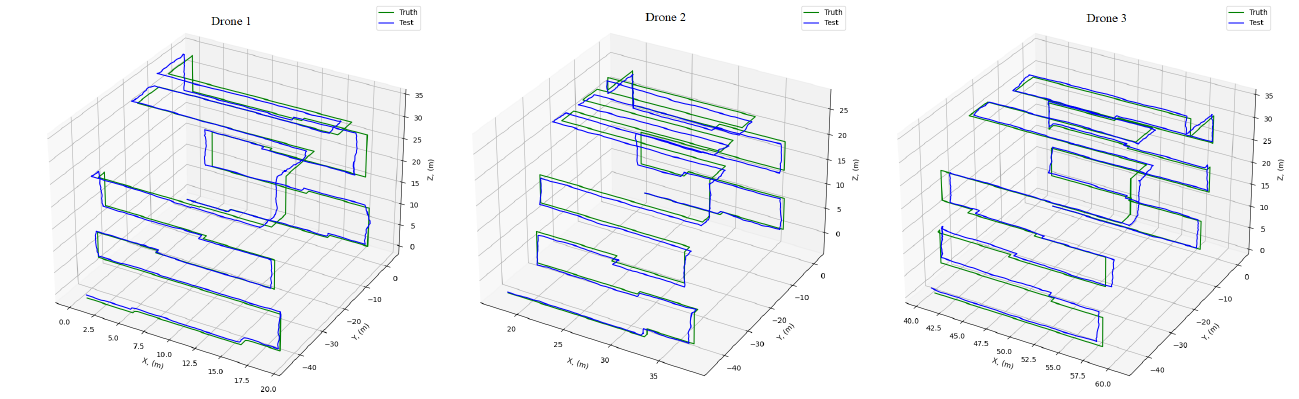
Figure 9. Estimated trajectory of all drones and the groundtruth trajectory.